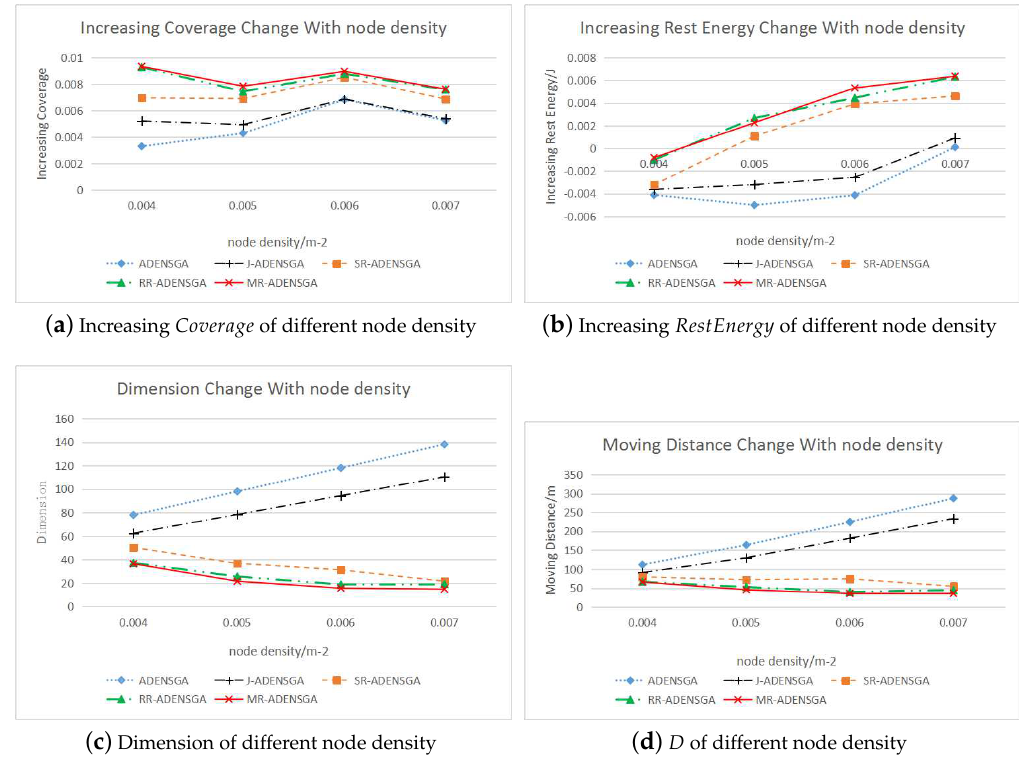
Figure 11. Comparison of Optimization Results for WSNs with Different Node